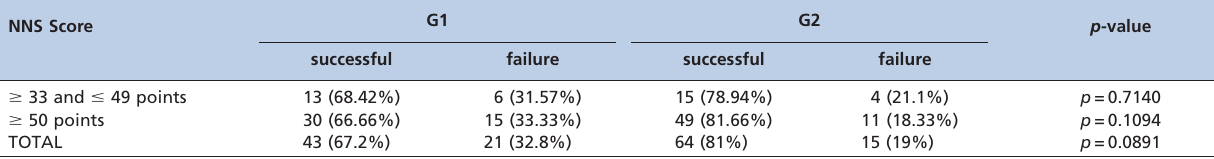
Table 2 - Distribution of infants (Groups 1 and 2) according to the score obtained and the results of the oral feeding. NNS